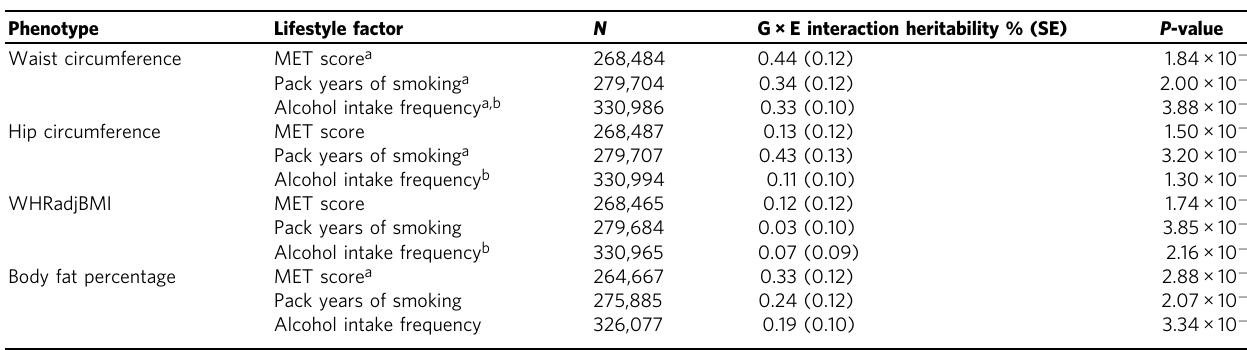
Table 5 G × E interaction heritability calculated using the LDAK-Sum Her